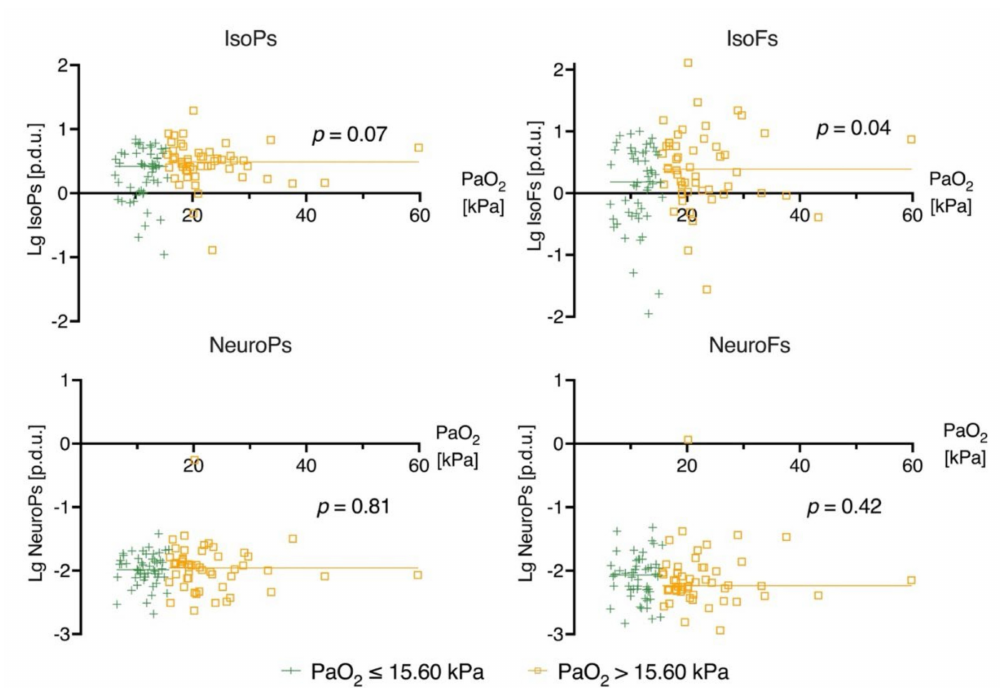
Figure 1. Scatterplot of biomarker and PaO 2 levels on ICU admission (0 h). The patients are divided into two groups by median PaO 2 value on intensive care unit admission. The straight lines seen in the plots represent the median values of the biomarker levels concerned. The p -value indicates the significance of the Mann–Whitney U test between the biomarker level on admission in the patients’ PaO 2 below vs. above the median (15.60 kPa). Definitions of abbreviations: